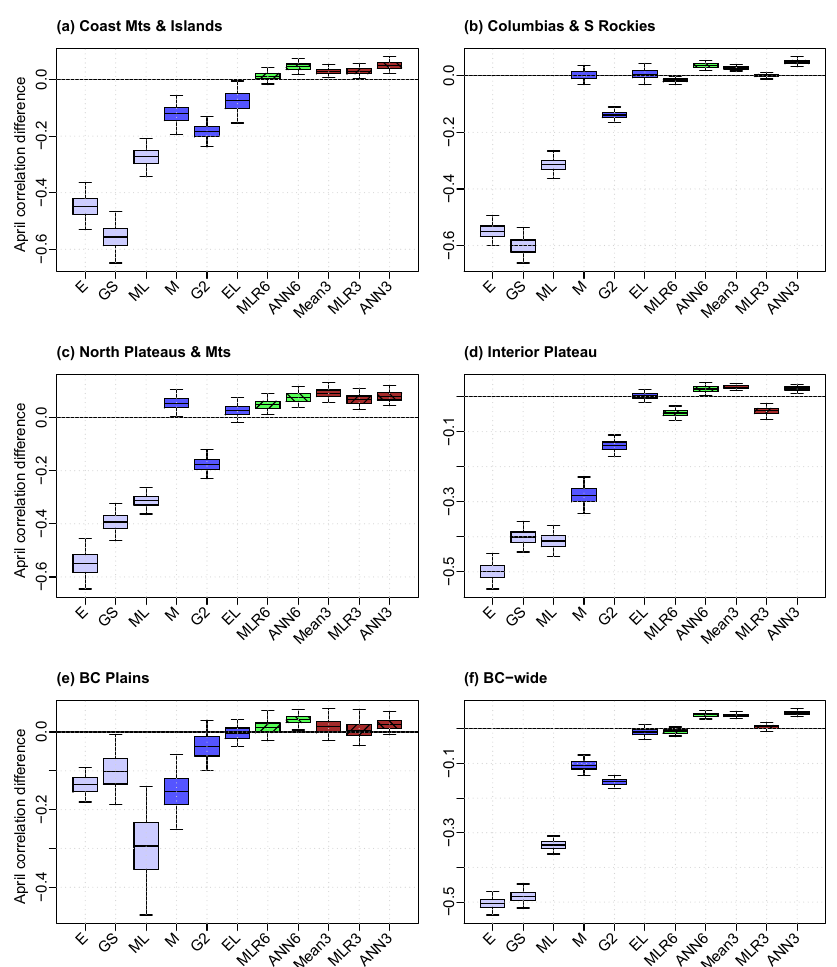
Figure 7. Bootstrap mean station April correlation differences between several SWE products/combinations and the reference (the mean of six products). Quartiles and 95% confidence intervals are shown for regions of BC in order of descending mean accumulations: (a) Coast Mountains and Islands, (b) Columbia Mountains and Southern Rockies, (c) Northern Plateaus and Mountains, (d) Interior Plateau, (e) BC Plains, and (f) province-wide. Product and combination abbreviations and colors are as in Fig. 4. Note differences in vertical